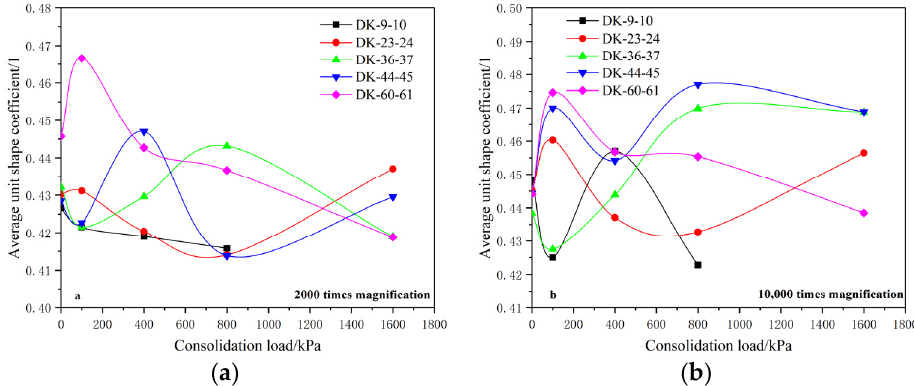
Figure 7. Relationship between the average unit shape coefficient and the consolidation load. ( a ) 2000 times magnification; (b) 10,000 times